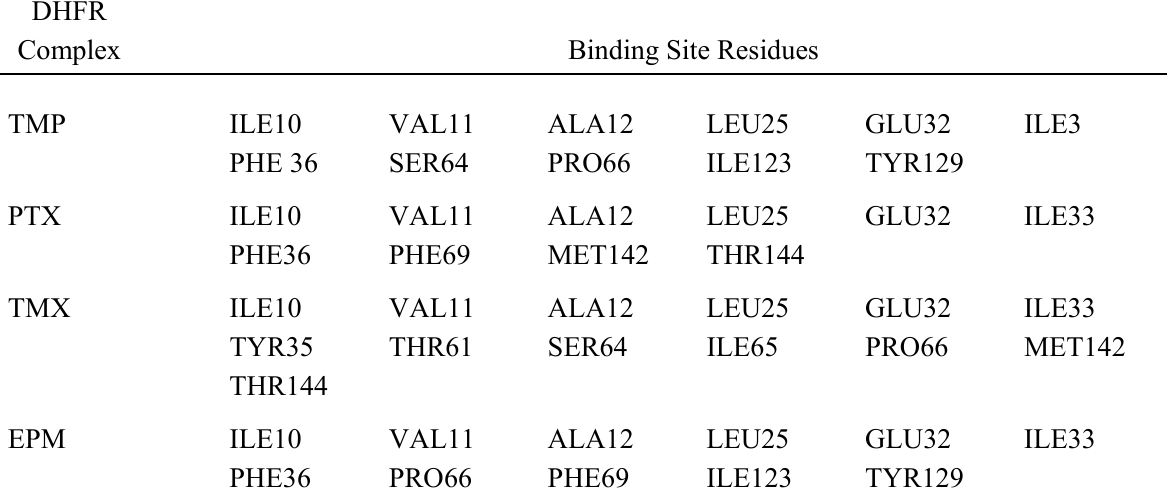
Table 1 . Comparison of Binding Site Residues for Each Antifolate/DHFR Complex DHFR